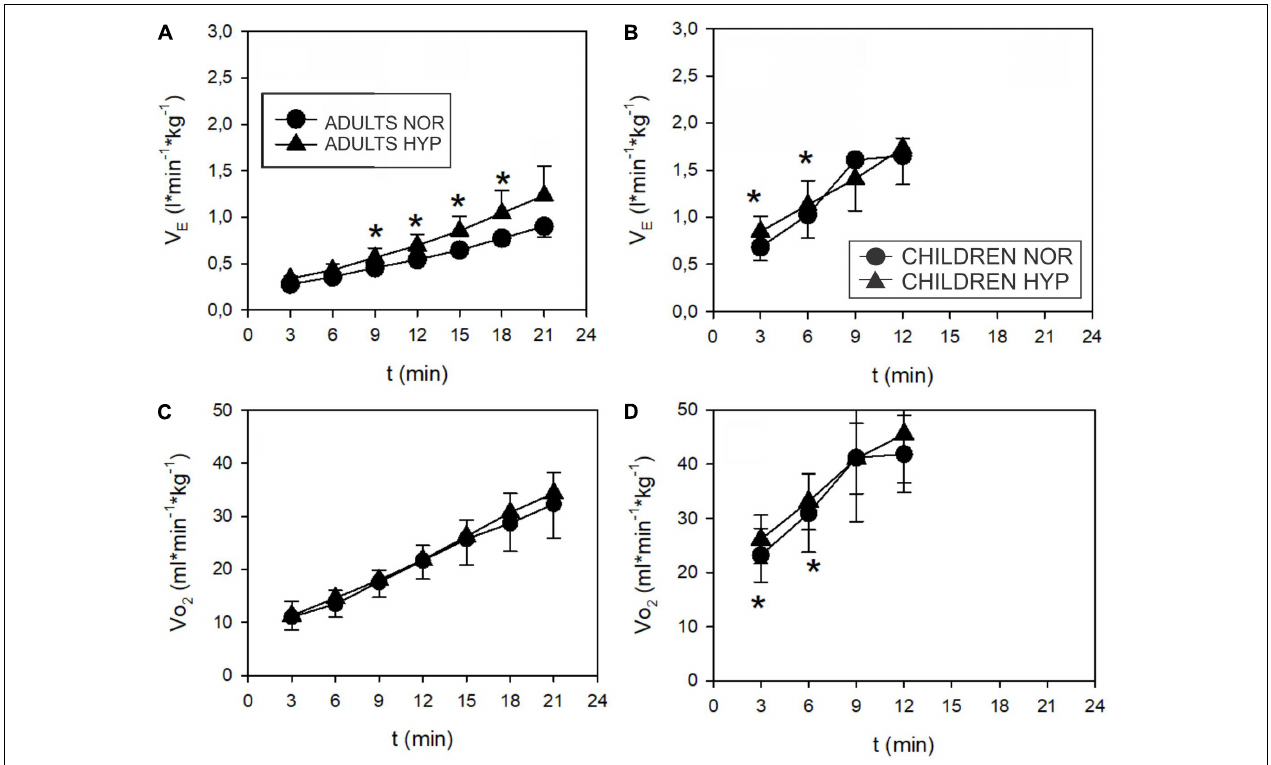
FIGURE 3 | Time course of minute ventilation ( ˙ V E ) and oxygen uptake ( ˙ Vo 2 ) (values normalized to body mass) during incremental test in adults (A,C) and children (B,D) . Adults increased ˙ V E more ( ∗ p < 0.05) in hypoxia ( (cid:78) ) than in normoxia ( Children increased their ˙ V E and ˙ Vo 2 at 3 and 6 min (below VT) ( ∗ p < 0.05) in hypoxia ( (cid:78) ) more than in normoxia (